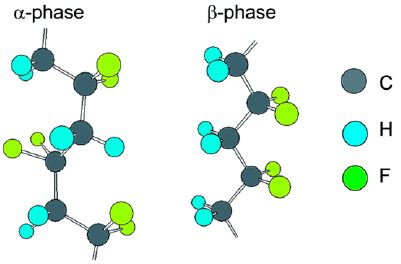
Figure 8. Structures of alpha and beta PVDF.